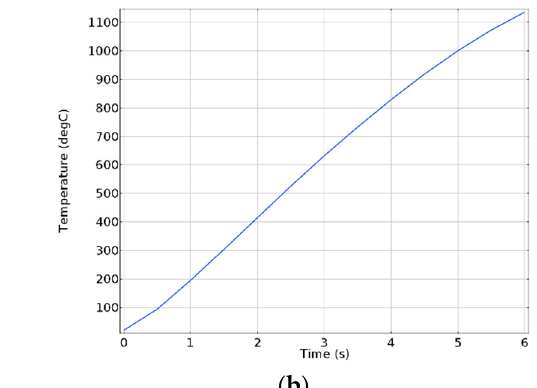
( b ) Figure 6. Heating—brazing assembly (copper), ( a ) heat source, ( b ) temperature distribution after 6 s. The final resulting heating of the brazing assembly is one that can be observed during real laboratory or industrial tests. However, it is not so easy to be analyzed or even measured as the process times are relatively short. The simulation approach allows more detailed study and estimation at any moment. Figure 6b presents the temperature distribution over the brazing assembly after 6 s of heating. It matches very well to the test results. The results for the more detailed analysis about our case are presented in the following figures. Using the simulation, we managed to compare two cases common for the industrial practice— brazing of copper-to-copper pipes and brazing of stainless-steel pipes. Brazing of these two cases requires similar temperatures to be reached in order to melt the brazing alloy ring and provide good flow into the gap between the pipes. Copper pipes are brazed by using an alloy with a melting temperature in the range of 640–720 °C. The requested temperature into the brazing area is around 800 °C. Figure 7a shows that this value was achieved at around 3.5 s after the start. At this point, it is reasonable to slow down the heating (by lowering the power) and